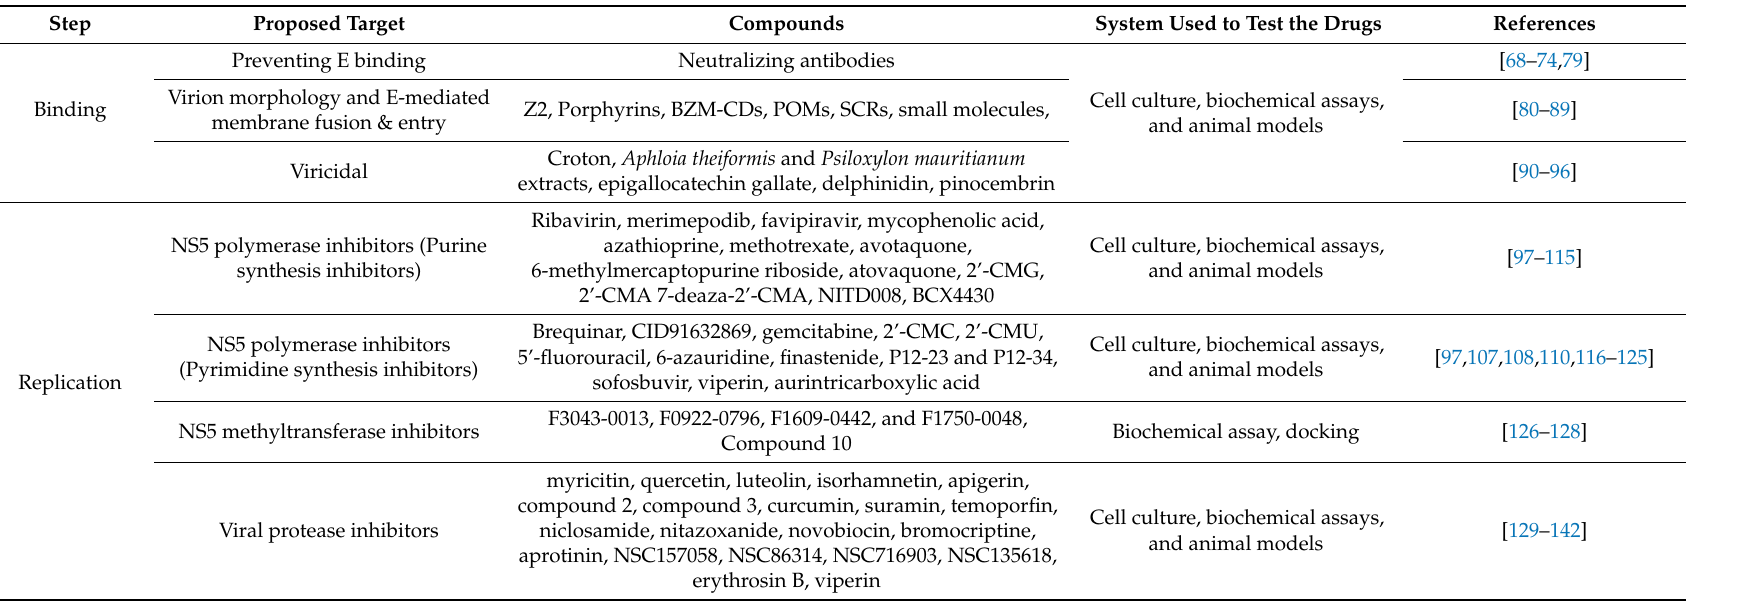
Table 2. Direct acting antivirals (DAAs) against